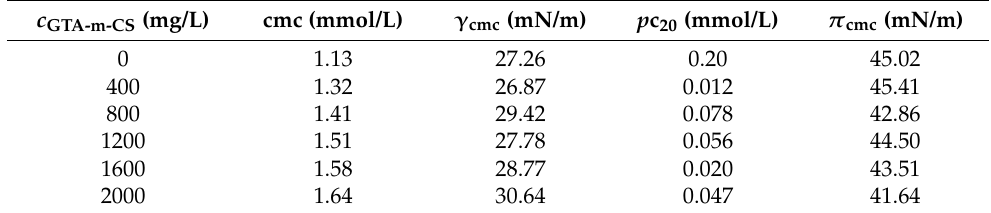
Table 1. Parameters of GTA-m-CS/DDEAC Systems with Different Concentration of GTA-m-CS at 20 ◦ C.